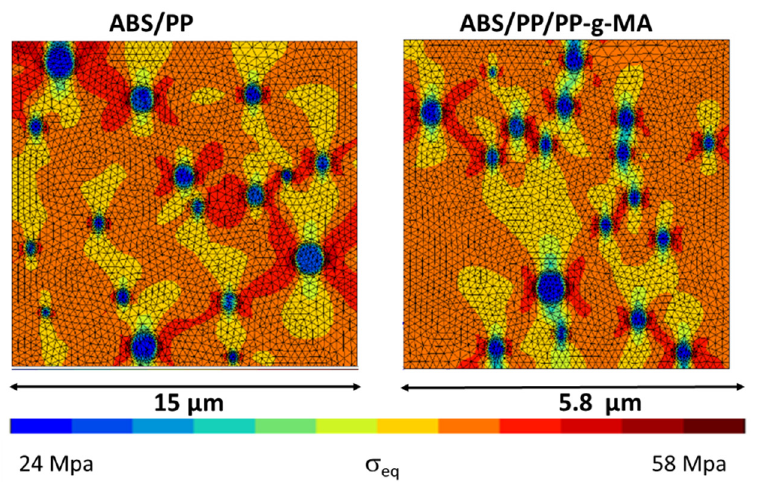
Figure 18. Von Mises stress cartography at 1.7% of macroscopic strain in ABS/PP and ABS/PP/PP- g-MA blends.